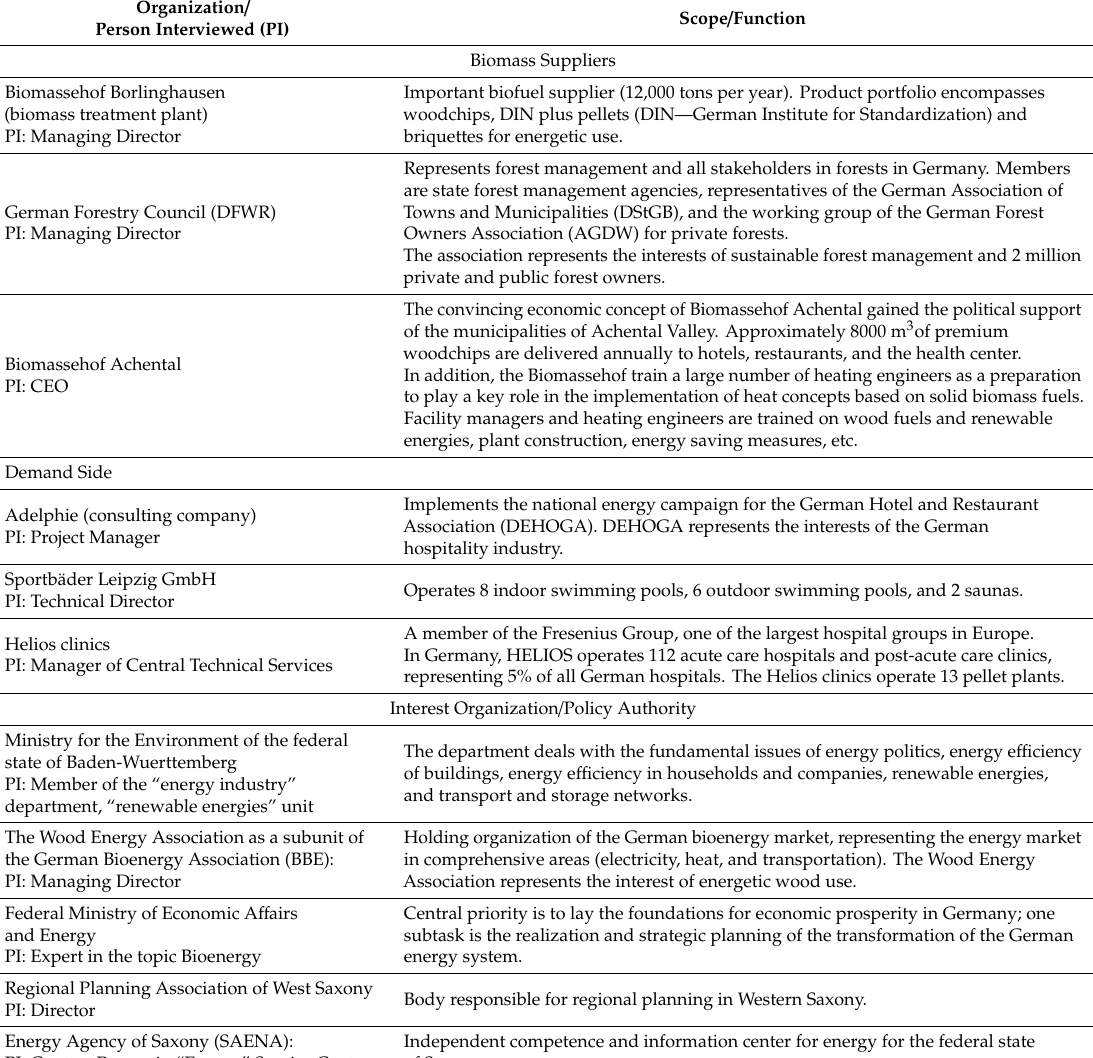
Table A2. Person / organization interviewed in the second